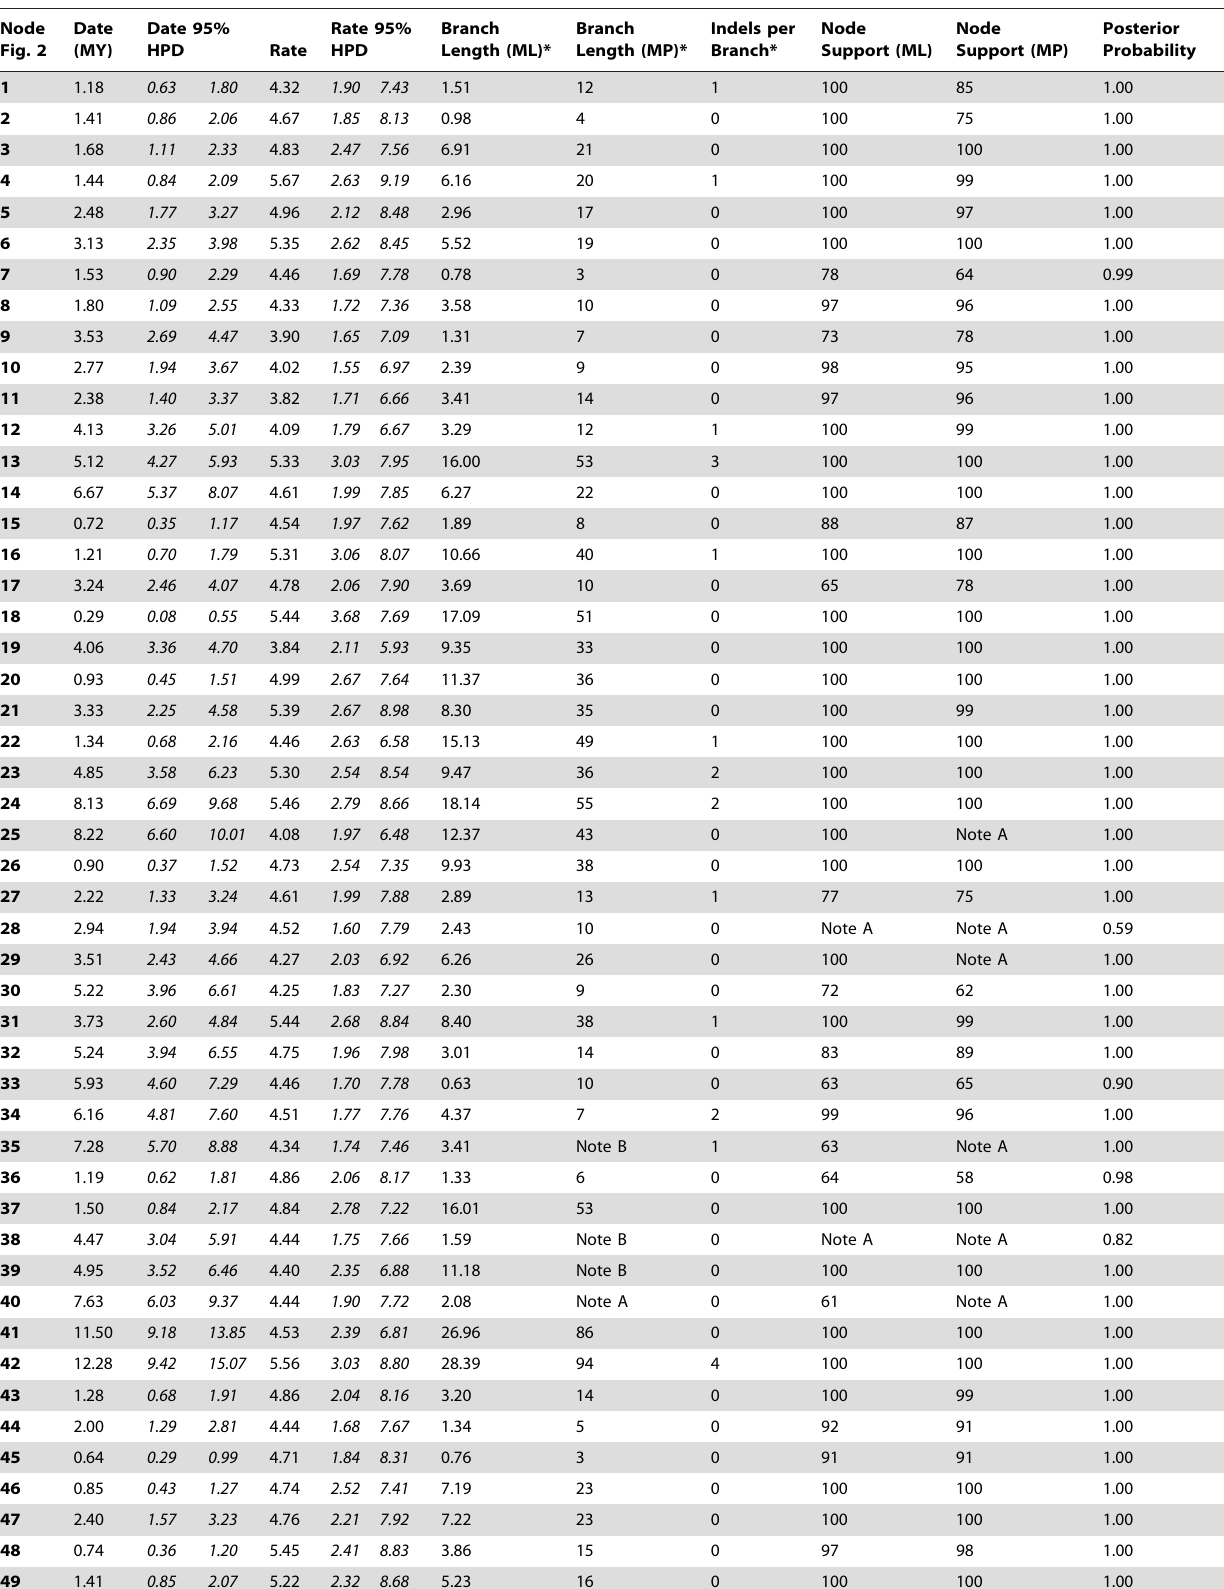
Table 3. Node Support, Branch Lengths, Divergence Times, and Nucleotide Substitution Rates for Catarrhini in Figure 2.